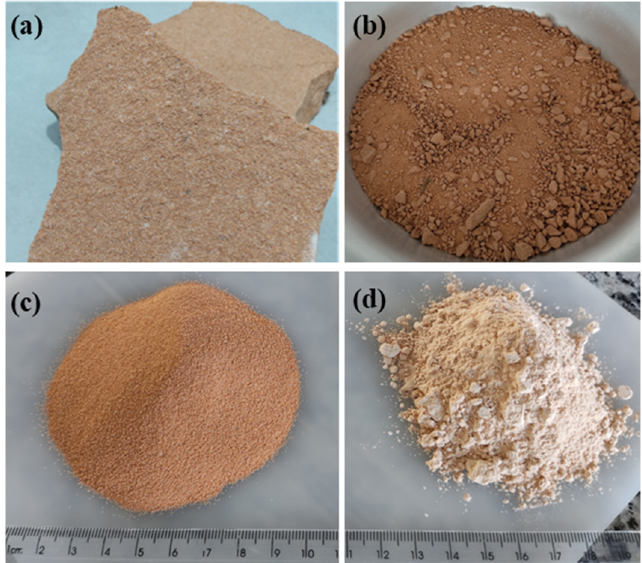
Figure 1. Ornamental sandstone waste (OSW) powder preparation ( a ); manually comminuted ( b ); particles < 30 µm ( c ); and OSW as filler ( d ).